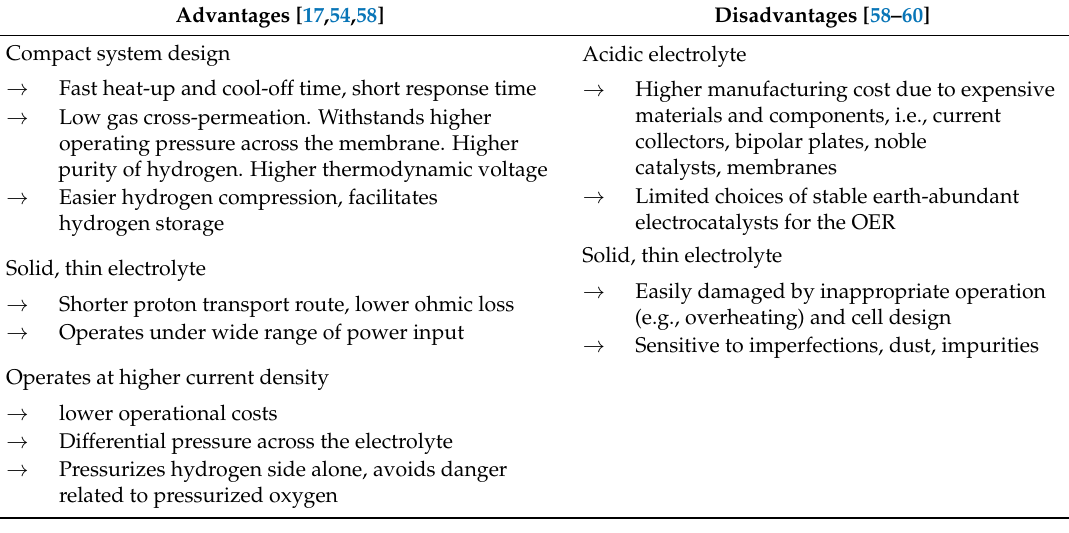
Table 1. Advantages and disadvantages of PEM WE over alkaline water